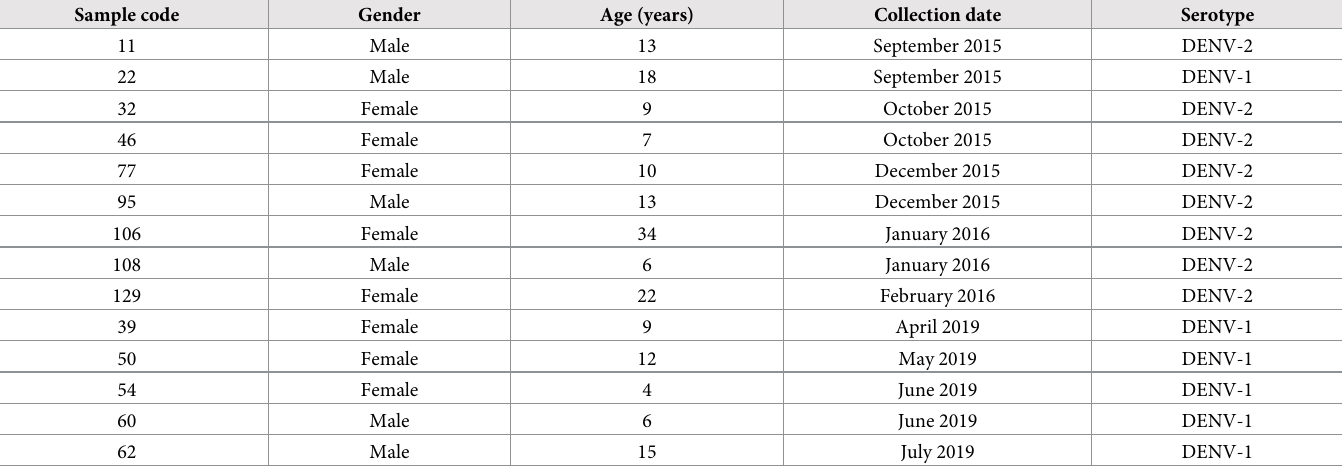
Table 1. Demographic information of patients from whom the DENV E protein genes were sequenced. Sample